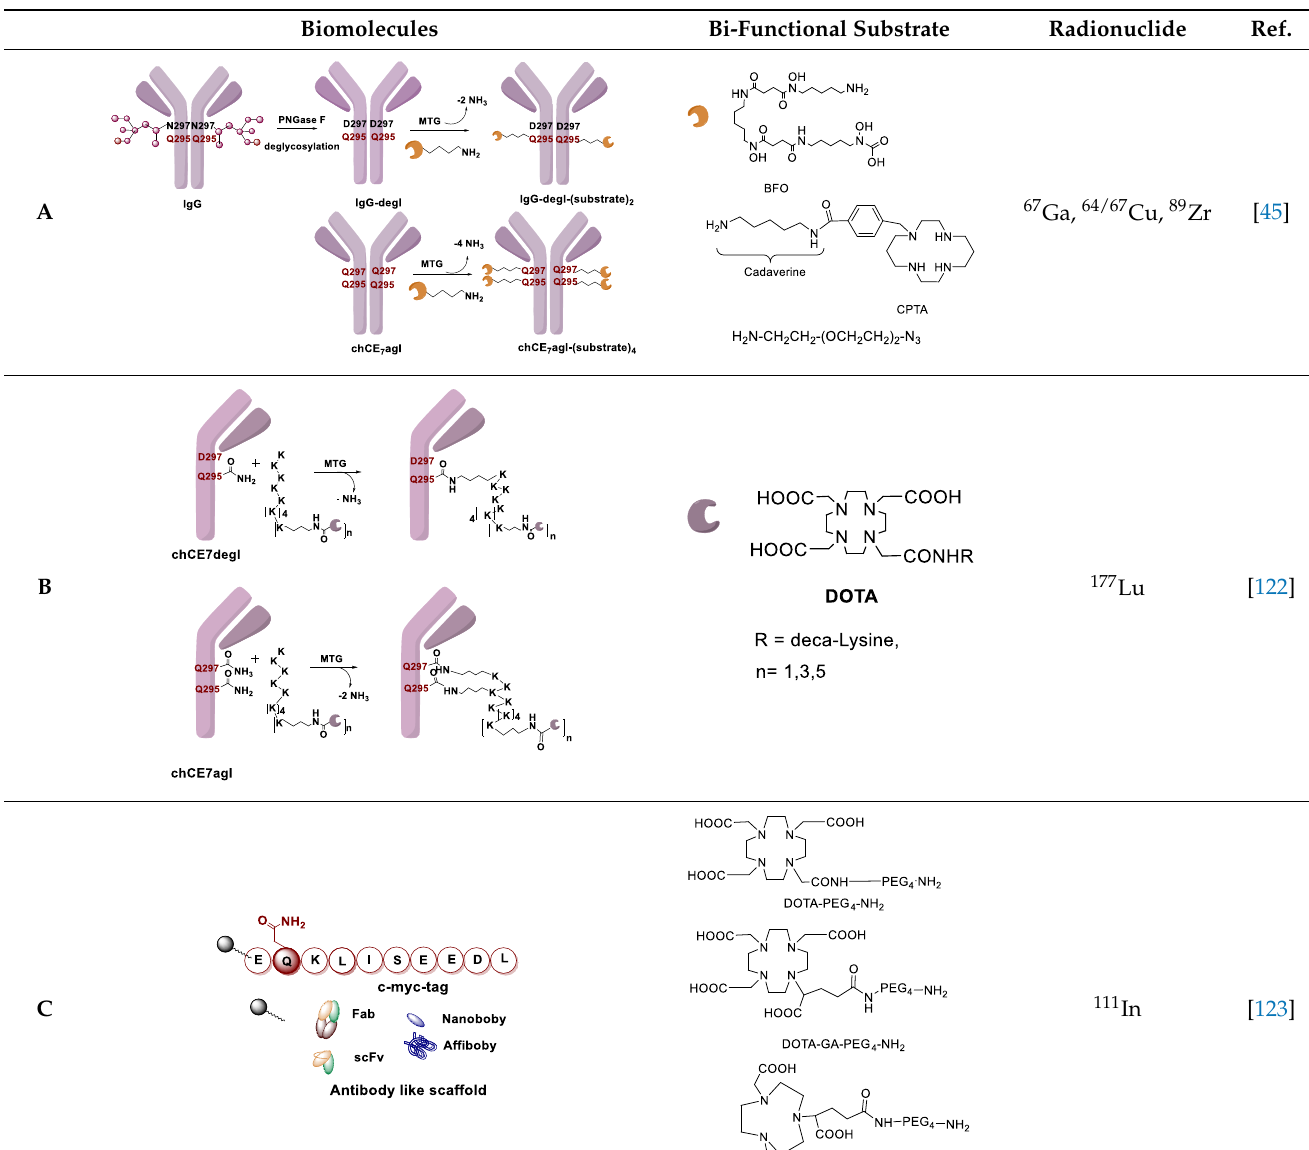
Table 5. Overview of TGase-mediated conjugation in radiopharmaceutical applications.